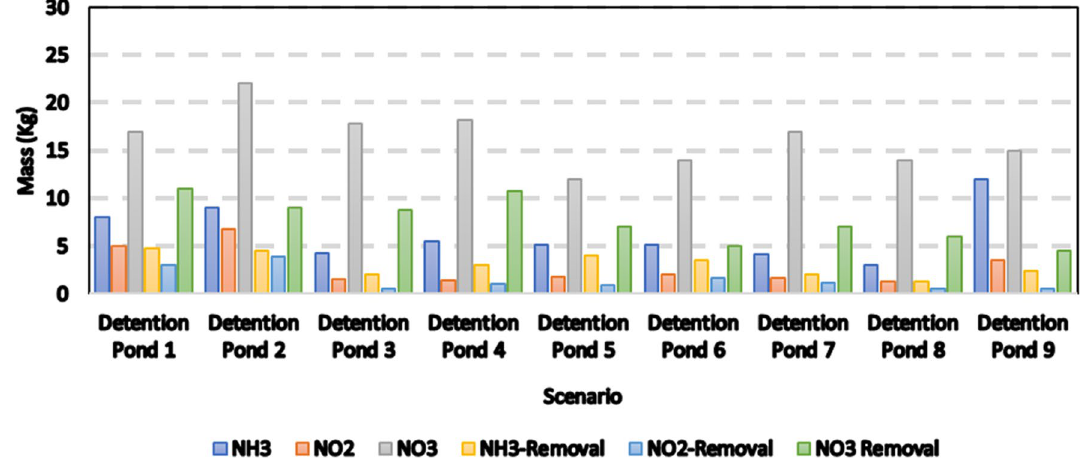
Figure 13. Percent removal of NH 3 , NO 2 , and NO 3 in the storm runoff for different scenarios of detention